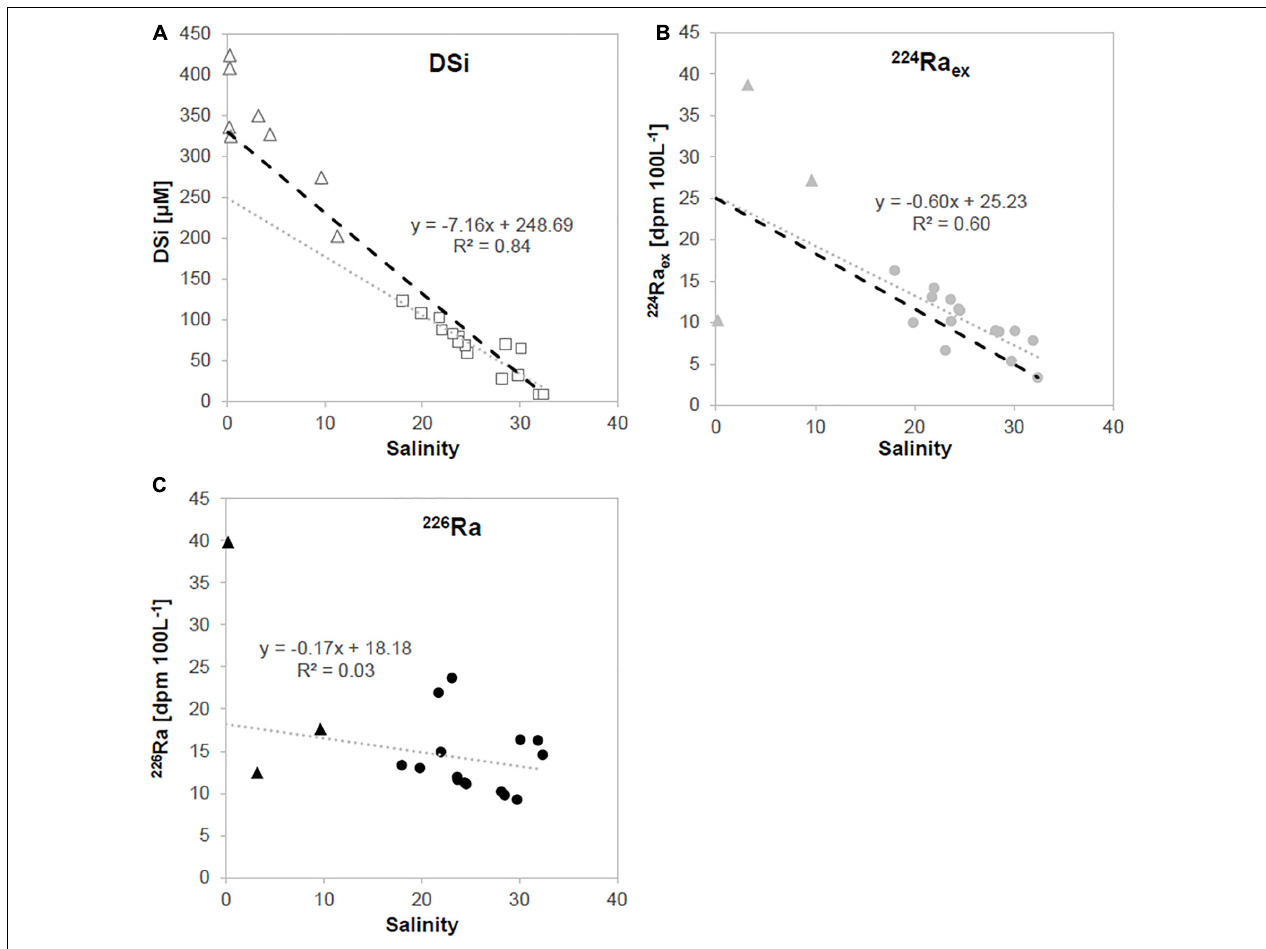
FIGURE 2 | Salinity plotted against (A) DSi, (B) 224 Ra ex and (C) 226 Ra concentrations of water samples taken in an embayment in a karstic region in southern Java. Squares and dots represent surface water column measurements and triangles represent samples taken at coastal and submarine springs. Gray dotted lines show linear correlations of samples taken from the water column, while black dotted lines indicate theoretical conservative mixing between the average groundwater concentration and seawater. Note that only selected spring samples were analyzed for Ra isotopes.